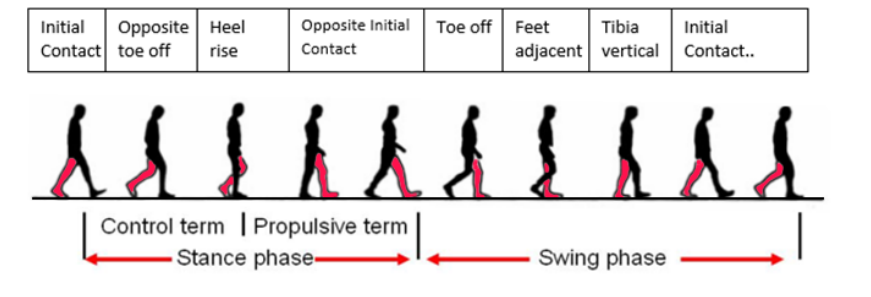
Figure 2. The seven sequential phases of the gait cycle.